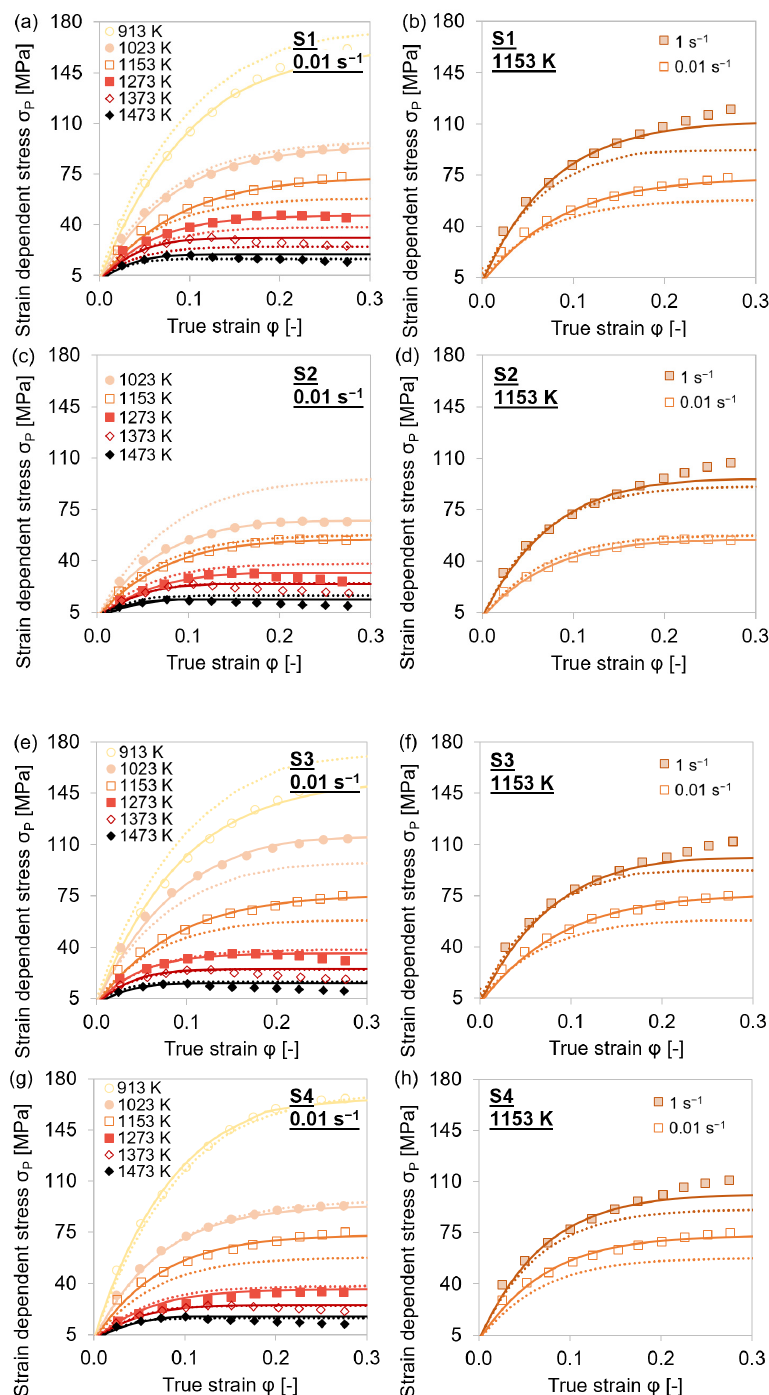
Figure 16. Comparison of experimental (symbols), simulated with experimentally determined ABC parameters (lines), and simulated with ABC parameters calculated from equation (dotted lines) flow curves during single-hit compression tests with 25 s holding time before deformation of steel grades . . ϕ = 0.01 s − 1 ; ( b , d , f , h ) T = 1153 K, ϕ = 0.01–1 s − 1 S1–S4. ( a , c , e , g ) T = 913–1473 K,